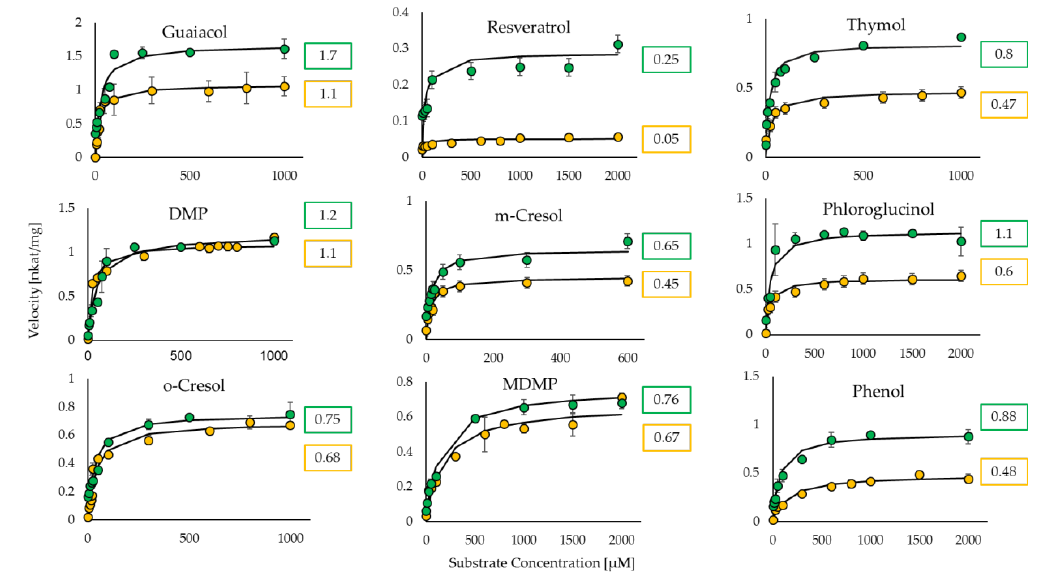
Figure 3. Graphical representation of the Michaelis–Menten curves for the substrates glycosylated by UGT72B27 quantified with UDP-Glo TM assay (yellow) and phosphate GT activity assay (green). The numerical symbols represent the maximum velocity (V max ) for each corresponding curve with the unit nkat/mg. n = 3.